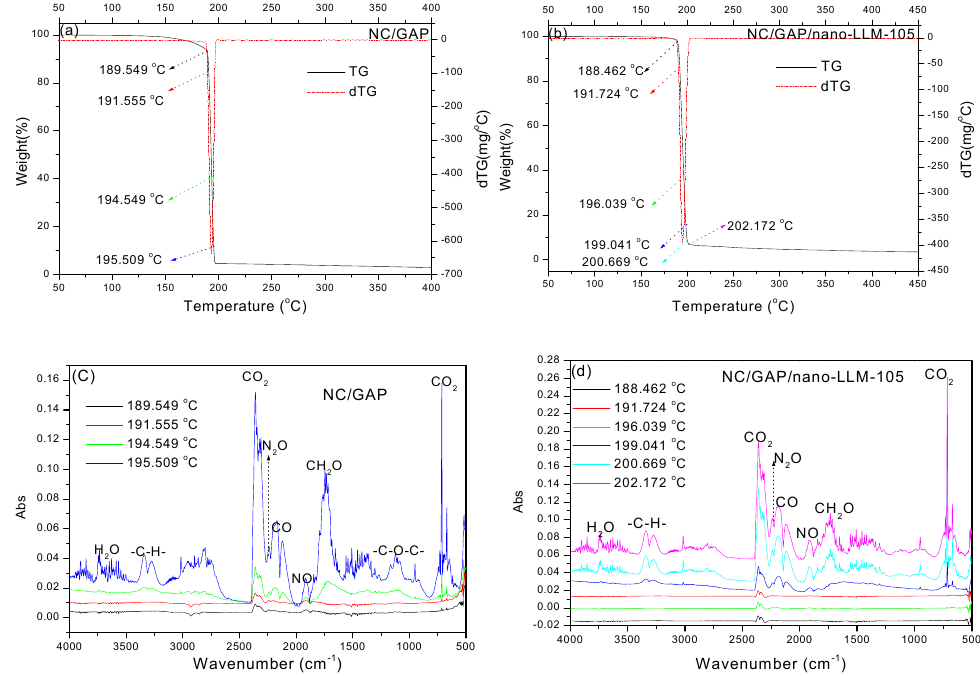
Figure 9. TG-IR analysis of samples: ( a,b ) TG and DTG curves; ( c,d ) IR spectra of the decomposition products at different temperatures. Table 4. Peaks and attributions.